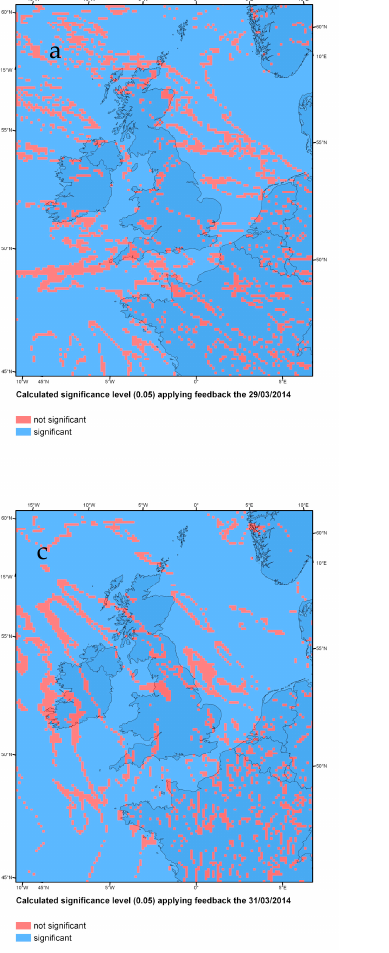
Figure 8. Calculated significance (blue) and no significance (red) with respect to the difference in daily mean pollen concentrations in applying radiative feedback vs. non-radiative feedback and for each of the days ( a – d ) 29 March–1 April, going from left to right. The results are based on the WRF-Chem calculations using the emission scenario without UK birch pollen emissions. The results are statistically significant with p -value = 0.05.